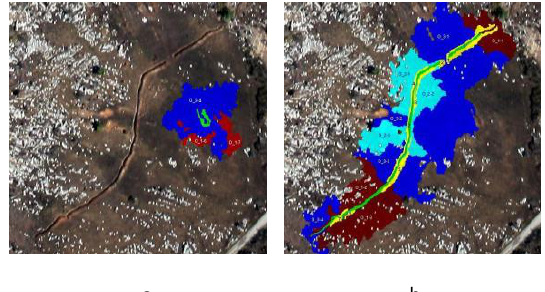
Figure 3. a) The cut part of the colour (RGB) image (Canon EOS 5D) of the trench 3 and the buried artillery cover 2 (green) and the surrounding area (red and blue) in the hilly type of the terrain, and b) the presentation of the trench 3 (light green), the battlement 2 (yellow) and the surrounding pattern (red, light and dark blue) on the same image (ITF, 2008).